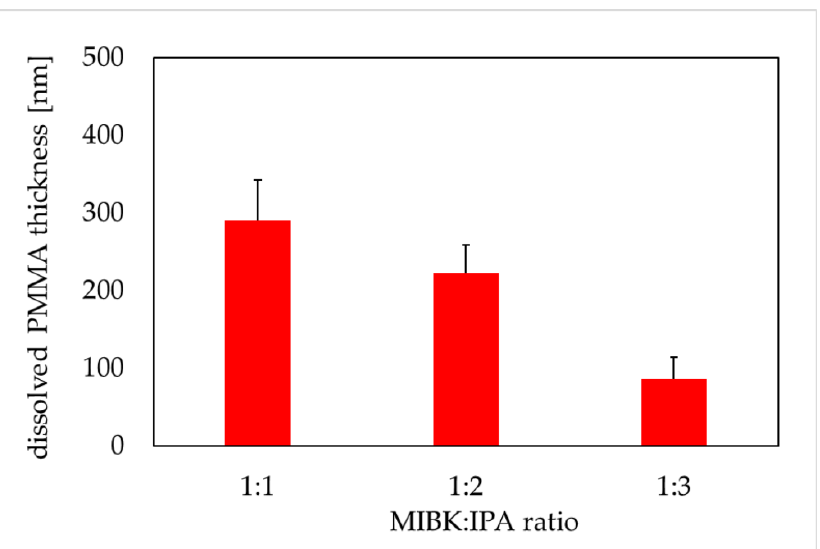
Figure 3. Dissolved polymethyl methacrylate (PMMA) thickness versus MIBK:IPA ratio (600 soft X-ray (SXR) pulses, the development time of 4 min). PMMA thickness was obtained from atomic force microscopy images (AFM, di CPII Veeco) as described in Material and Methods. Data are expressed as a mean ± standard deviation from 10 images.